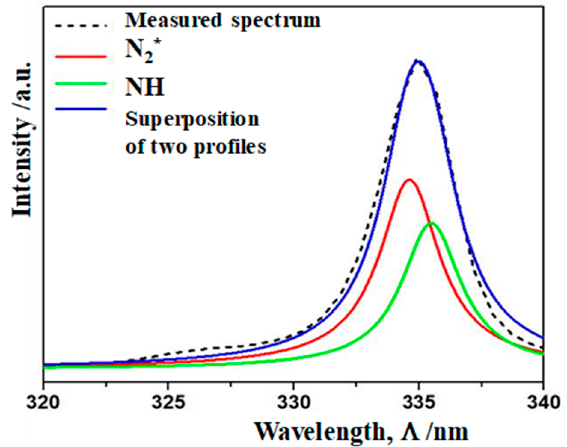
Figure 6. Detection of NH-radical by the N 2 + H 2 plasma diagnosis with the use of OES through wide and narrow scanning steps.